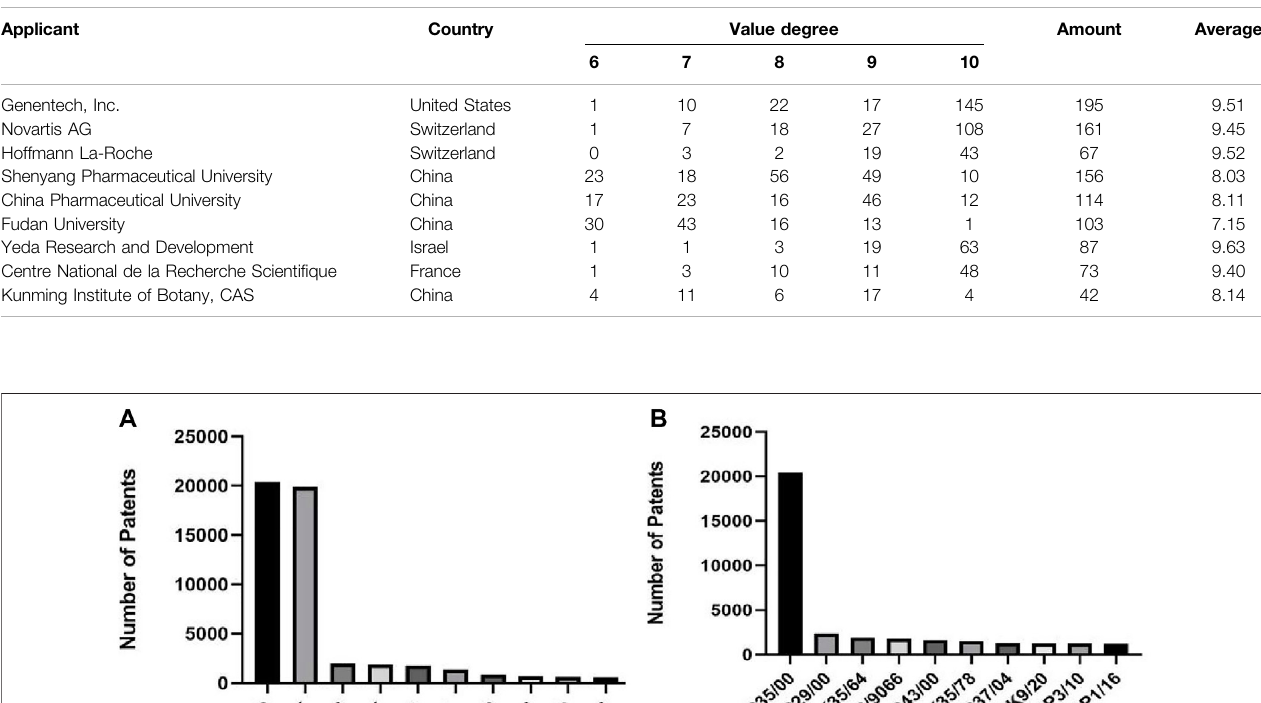
TABLE 1 | Distribution list of high-value patents of various types of applicants for anticancer natural products. Applicant Country